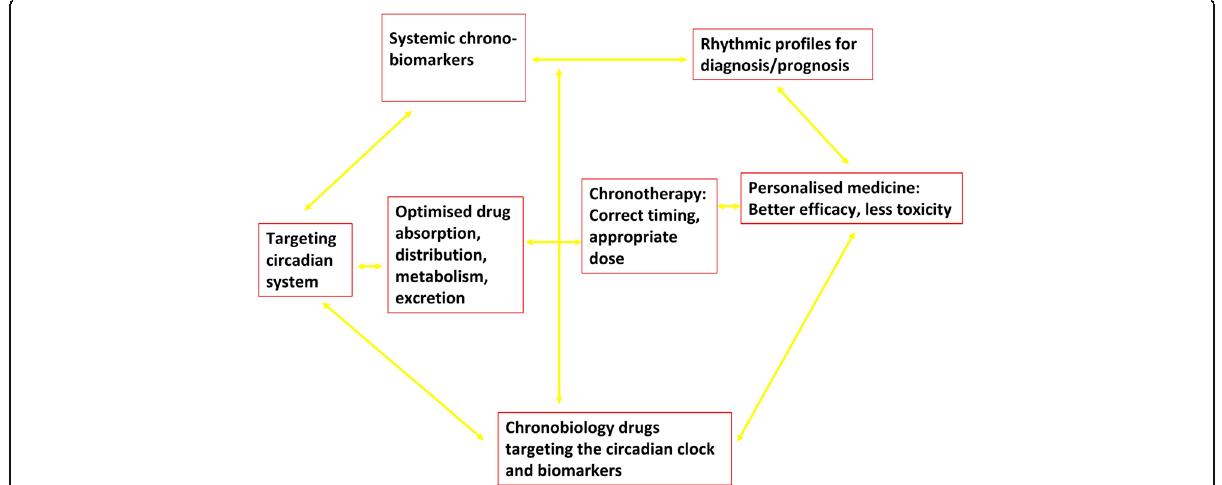
Fig. 1 A diagram showing a skeleton of chronobiology-based personalized medicine (Image reproduced with permission from the manuscript: ‘ Circadian Biomarkers and Chronotherapy: Implications for Personalized and Systems Medicine ’ by Yan et al. License Number